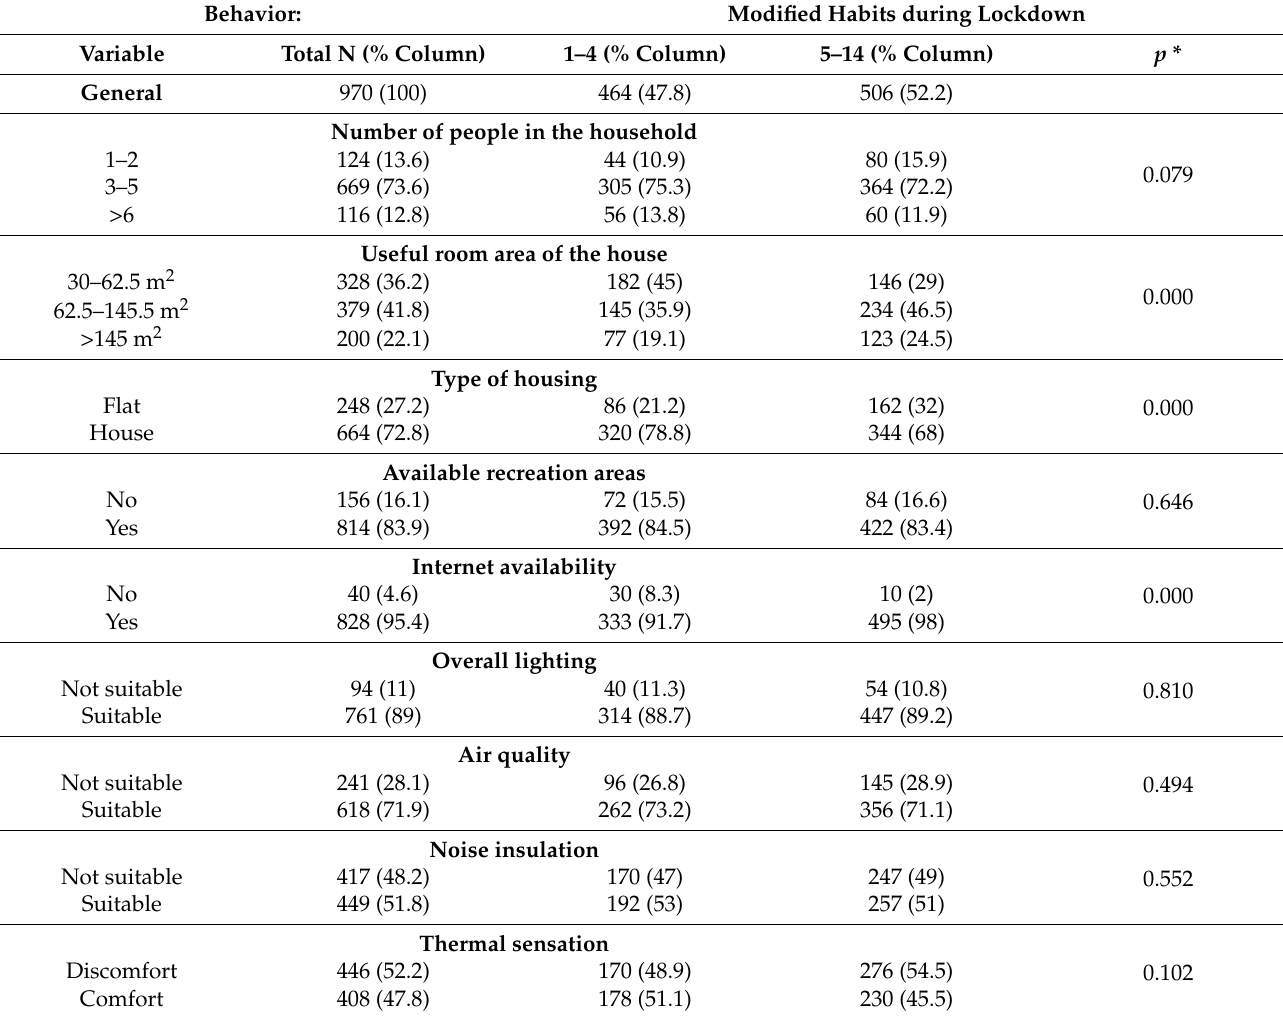
Table 4. Relationships between home features and